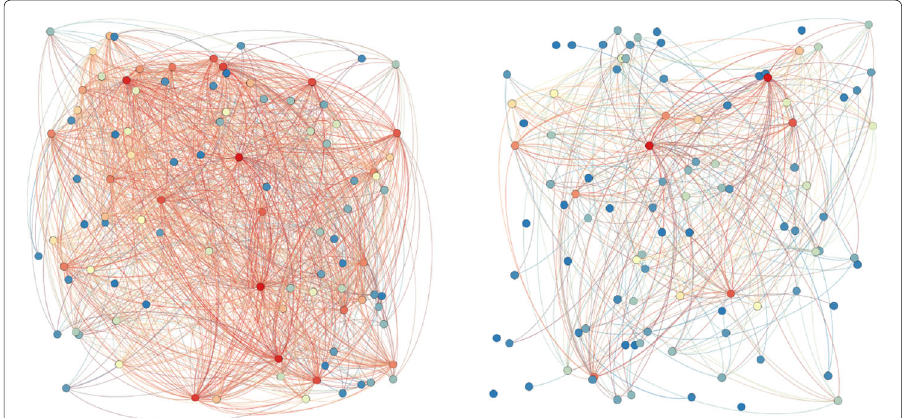
Fig. 12 Private metabolites networks: the left one corresponds to the minimum combined score (2), the right one corresponds to score values greater than 500. Warm colours for nodes indicate hight degree centralities. Warm colours for edges indicate hight